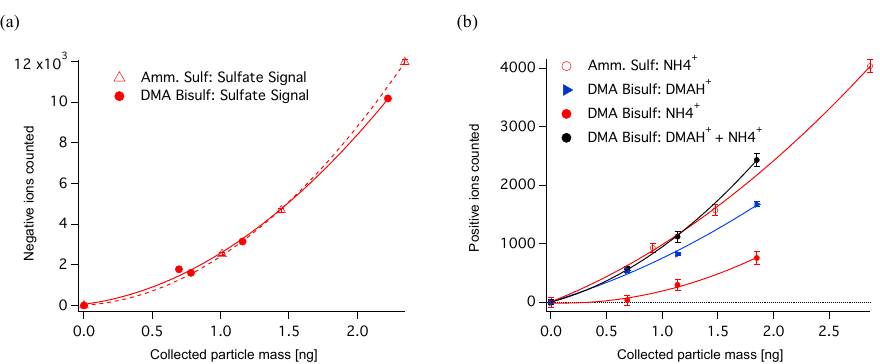
Figure 5. Results of a post-CLOUD7 calibration of the TDCIMS with salts generated by atomizing liquid solutions of ammonium sulfate, (NH 4 ) 2 SO 4 , and dimethylaminium bisulfate (DMABS), (C 2 H 8 N)HSO 4 . Particles of roughly 25nm volume median diameter were used for this calibration, and larger mass collections were achieved by collecting for longer periods. For these calibrations, particle volume was corrected to mass using the densities of DMAS (1.35gcm − 3 ) and AS (1.78gcm − 3 ) . (a) Signal in negative ion mode plotted against particle mass, with a second-order polynomial fit. The sulfate sensitivity for the two salts appears to be indistinguishable. (b) Signal in positive ion mode for the two salts. There was contamination of the DMABS by ammonium at some point between solution generation and analysis. Based on laboratory tests, this most likely occurs as a result of trace ammonia present in the carrier N 2 and transport lines. For this reason, the DMAH + signal, NH + signal, and their sum are all given. The sum signal for DMABS is very similar to the AS signal, suggesting that 4 both aerosols may actually have similar base:acid ratios after atomization and